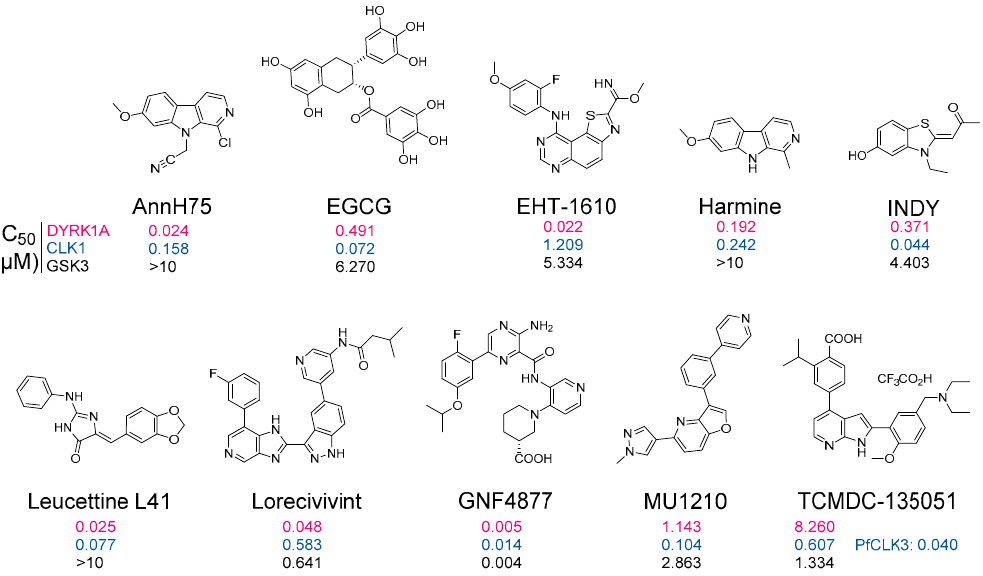
Figure 5. DYRK and CLK inhibitors and their potential use. ( A ) DYRK inhibitors (in particular in- hibitors of DYRK1A) have been investigated in the indicated diseases. ( B ) CLK inhibitors (in par- ticular inhibitors of CLK1) have been investigated in the indicated diseases.